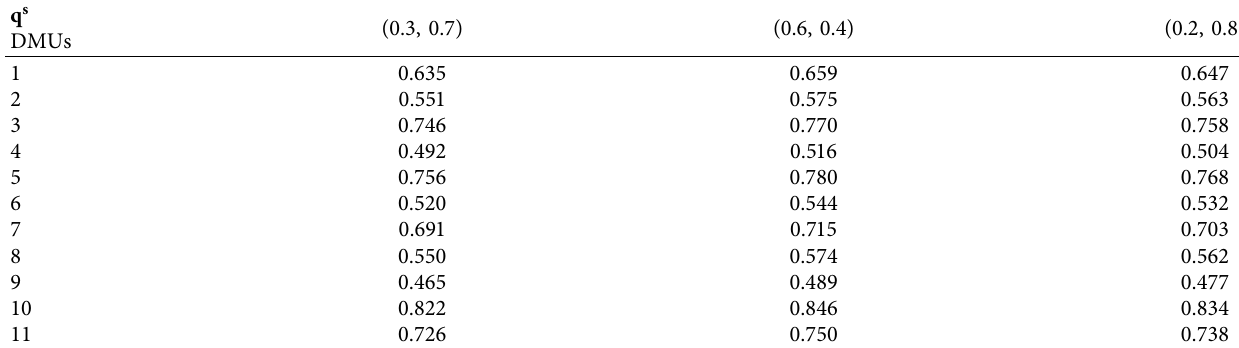
Table 13: The gap values of model